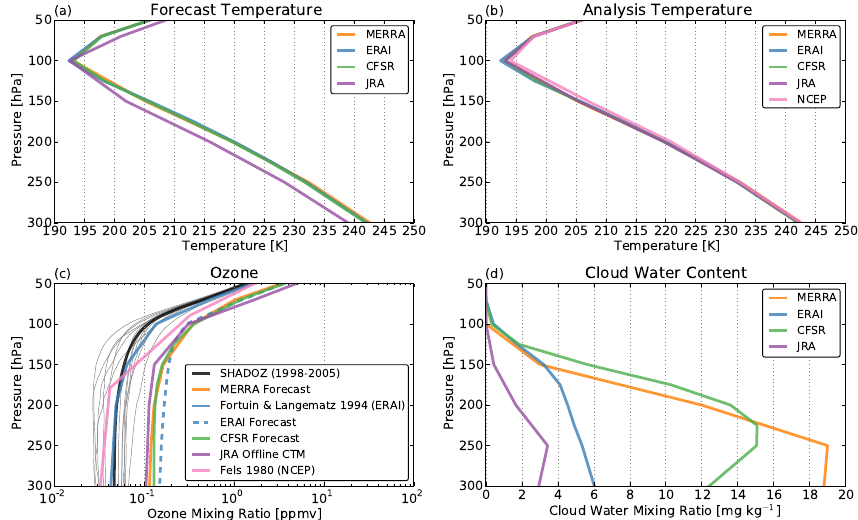
Fig. 1. Profiles of (a) forecast temperature (averaged over the forecast step prior to data assimilation), (b) analysis temperature (after data assimilation), (c) ozone mixing ratios, and (d) cloud water mixing ratios (combined ice and liquid water) averaged over the inner tropics (10 ◦ S–10 ◦ N). Thick coloured lines indicate terms used in the reanalysis radiative transfer calculations. The dashed blue line in (c) indicates ozone concentrations simulated by the ERAI forecast model (which are not used in radiative calculations). The thick black line in (c) indicates the climatological mean ozone profile averaged from observations at 13 SHADOZ sites in the tropics between 1998 and 2005 (Thompson et al., 2003; Fueglistaler and Fu, 2006); thin grey lines indicate climatological mean profiles at individual SHADOZ